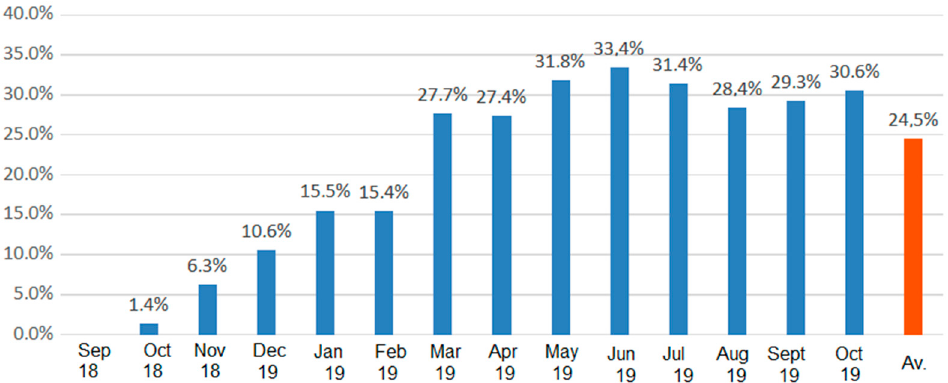
Figure 2. Recirculation ratio for REC-affiliated businesses (retailers) from October 2018 to October 2019.